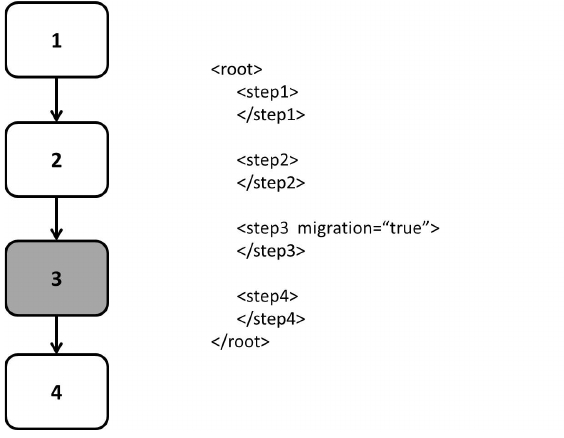
Figure 4: Emerald offloads computation step with migration attribute to the cloud.